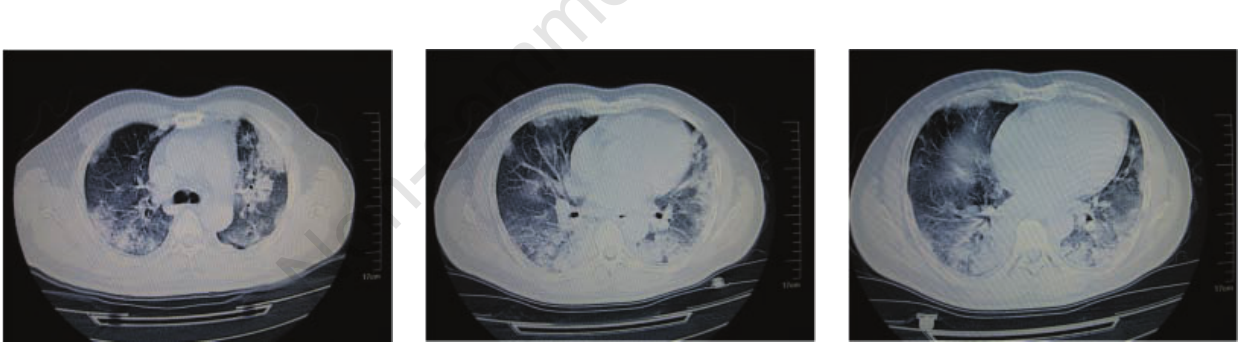
inflammation.Figure 1. Lung computed tomography. Lung computed tomography indicated a patchy dense shadow scattered in both lungs, in which the inflatable bronchial shadow was observed. The boundary of shadow was not clear. Visible change in leakage around shadow was